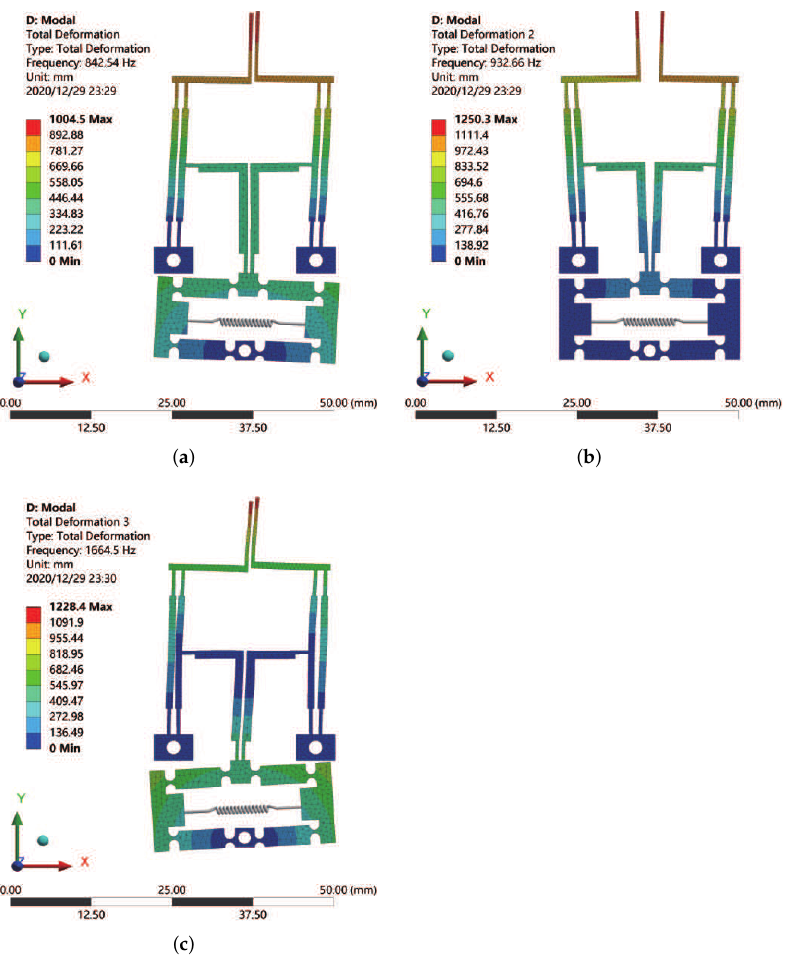
Figure 8. Simulation results of the first-three mode shapes of the microgripper. ( a ) The first modal, ( b ) the second modal, and ( c ) the third